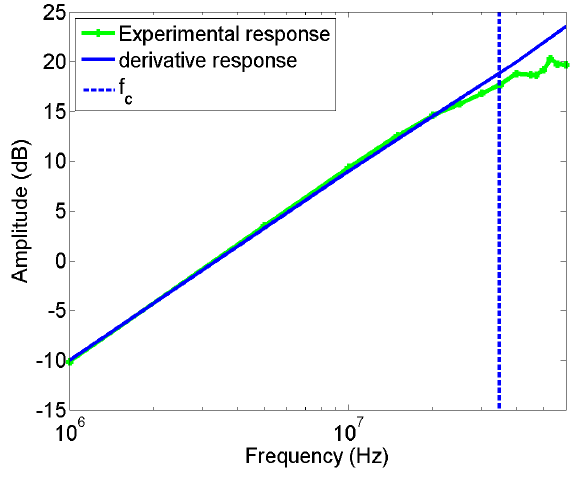
Figure 7. Experimental frequency and derivative response of the